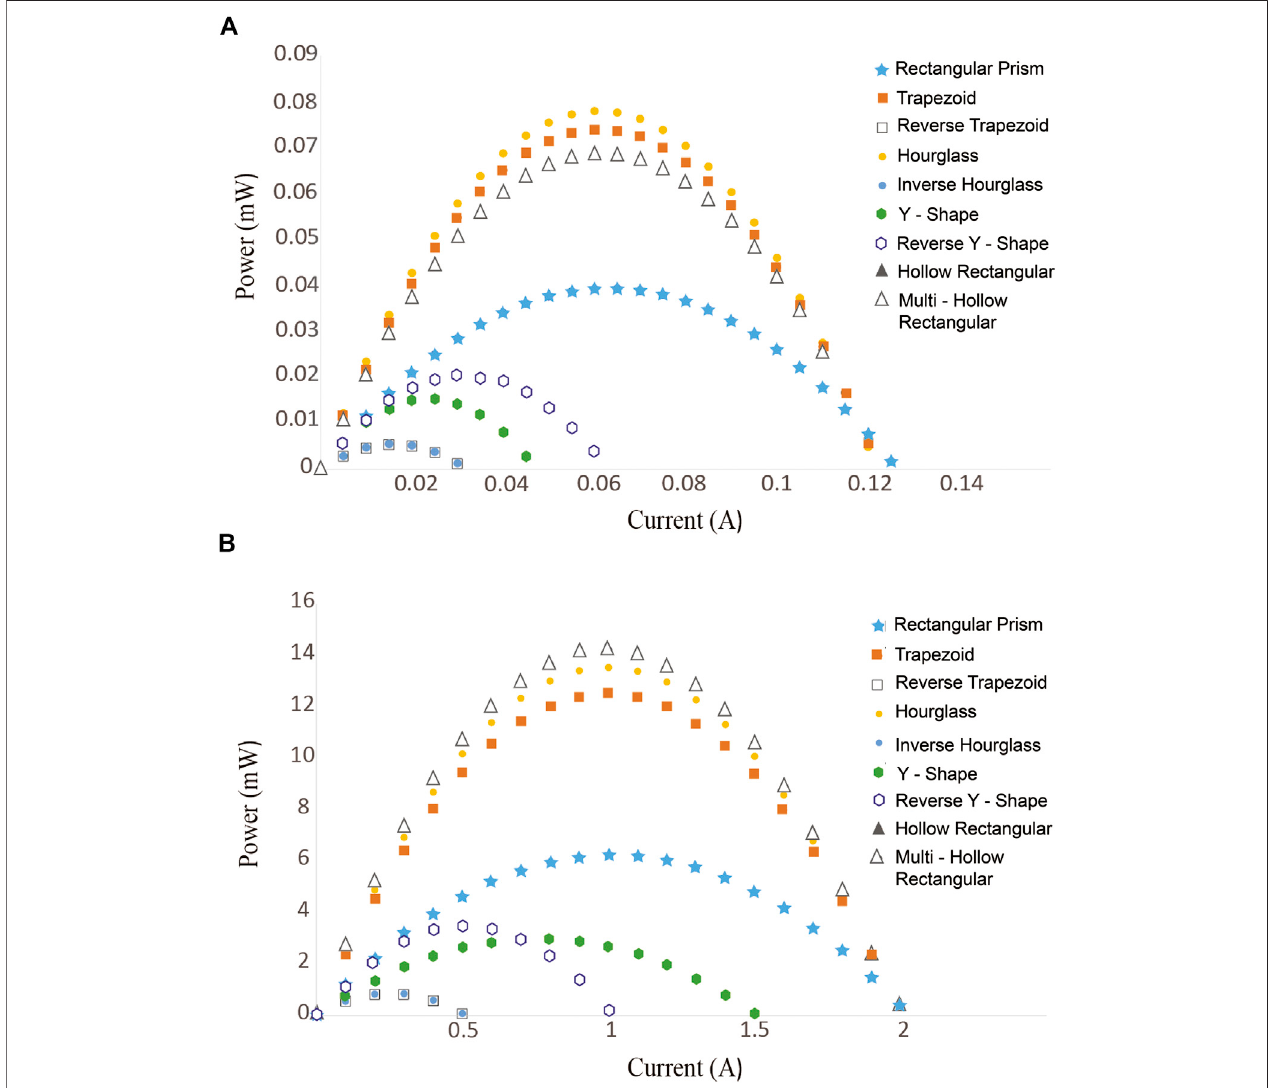
FIGURE 6 | Power generation potential as a function of current (load resistance) for various leg shapes are shown for constant hot side temperature ( T h ) and cold sideforcedconvection(convectioncoef fi cient h (cid:1) 20 W/m 2 -K)boundaryconditionsfor (A) (Bi 0.5 Sb 0.5 ) 2 Te 3 ( T h (cid:1) 100 C)and (B) Si 0.78 Ge 0.22 ( T h (cid:1) 1,000 C)legsofvarying